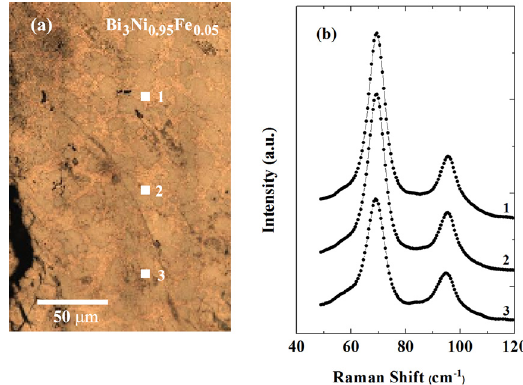
Figure 7. (a) Mapping of Bi 10 mW. Measurements were performed in 3 steps spaced by 50 μm starting from the top (1) and (b) the corresponding Raman spectra measured at room temperature.